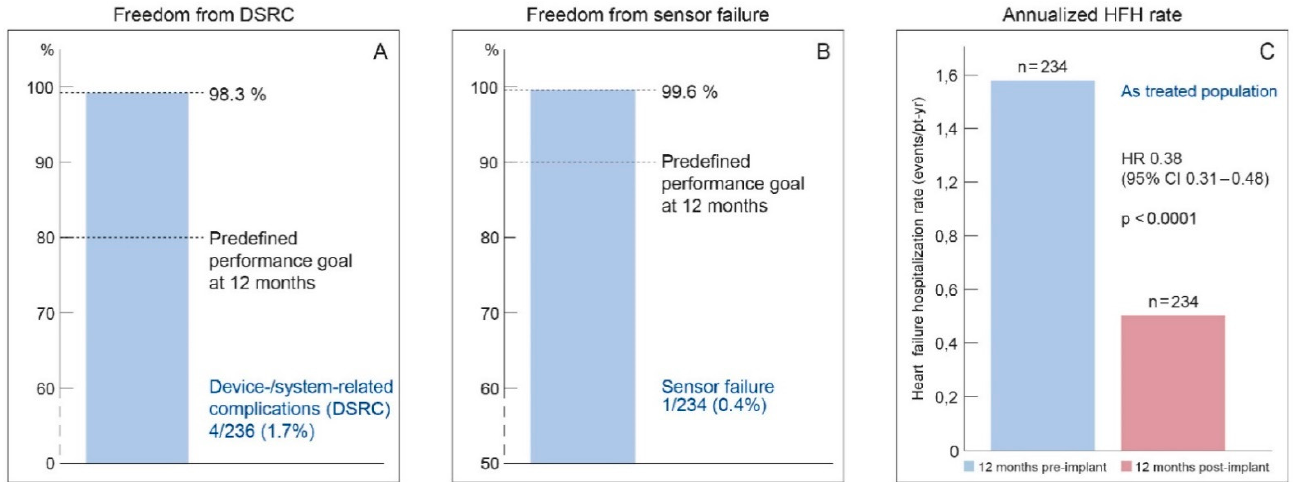
Figure 5. Annualized heart-failure-related hospitalization rates pre-implant and post-implant as reported in the MEMS-HF study. Reprinted from the European Journal of Heart Failure, Volume 22, Issue 10, Angermann et al., Pulmonary artery pressure-guided therapy in ambulatory patients with symptomatic heart failure: the CardioMEMS European Monitoring Study for Heart Failure (MEMS-HF), pages 1891–1901, with permission from Wiley [6].